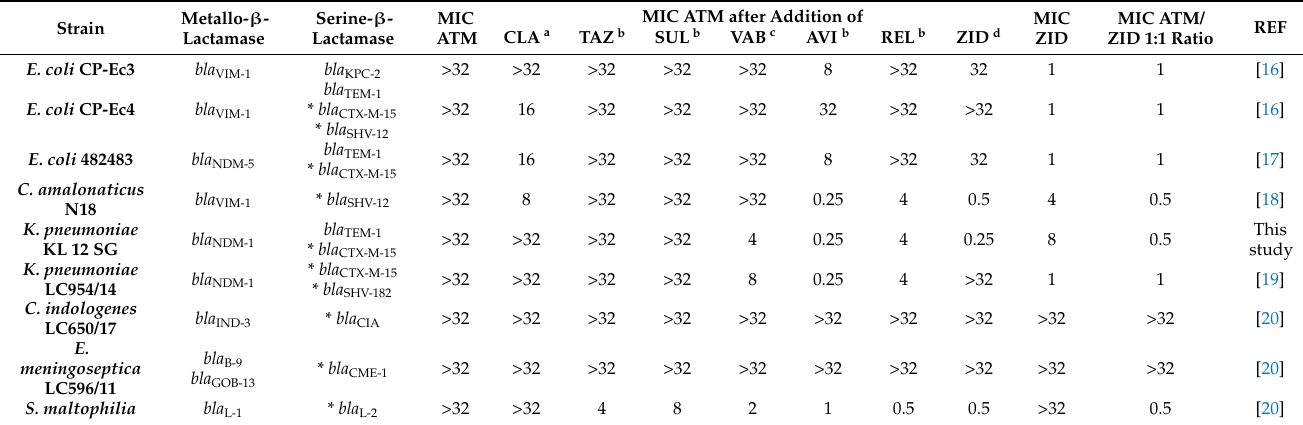
Table 1. MIC ( µ g/mL) of aztreonam, alone and in association with BLIs, of tested